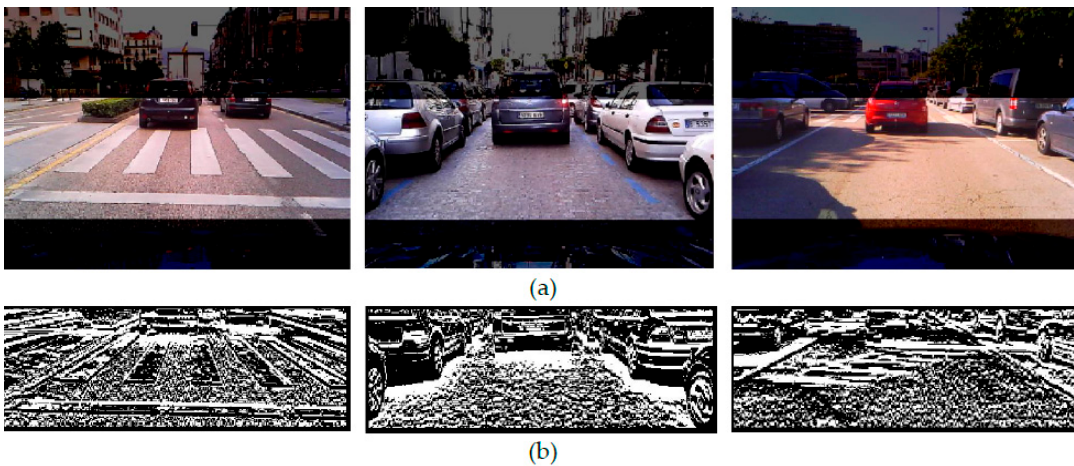
Figure 1. City centre roads with road markings, vehicles parked on both sides and cluttered bacgrounds in overcast and sunny conditions. ( a ) Searching image region ( b ) vertical intensity gradients M ( x , y ).